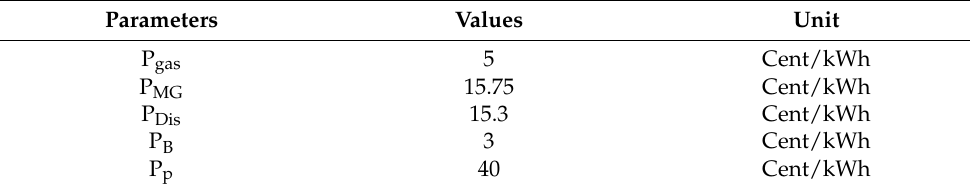
Table 3. Cost data. Reproduced from [49], the (Journal of Energy Storage): 2021.